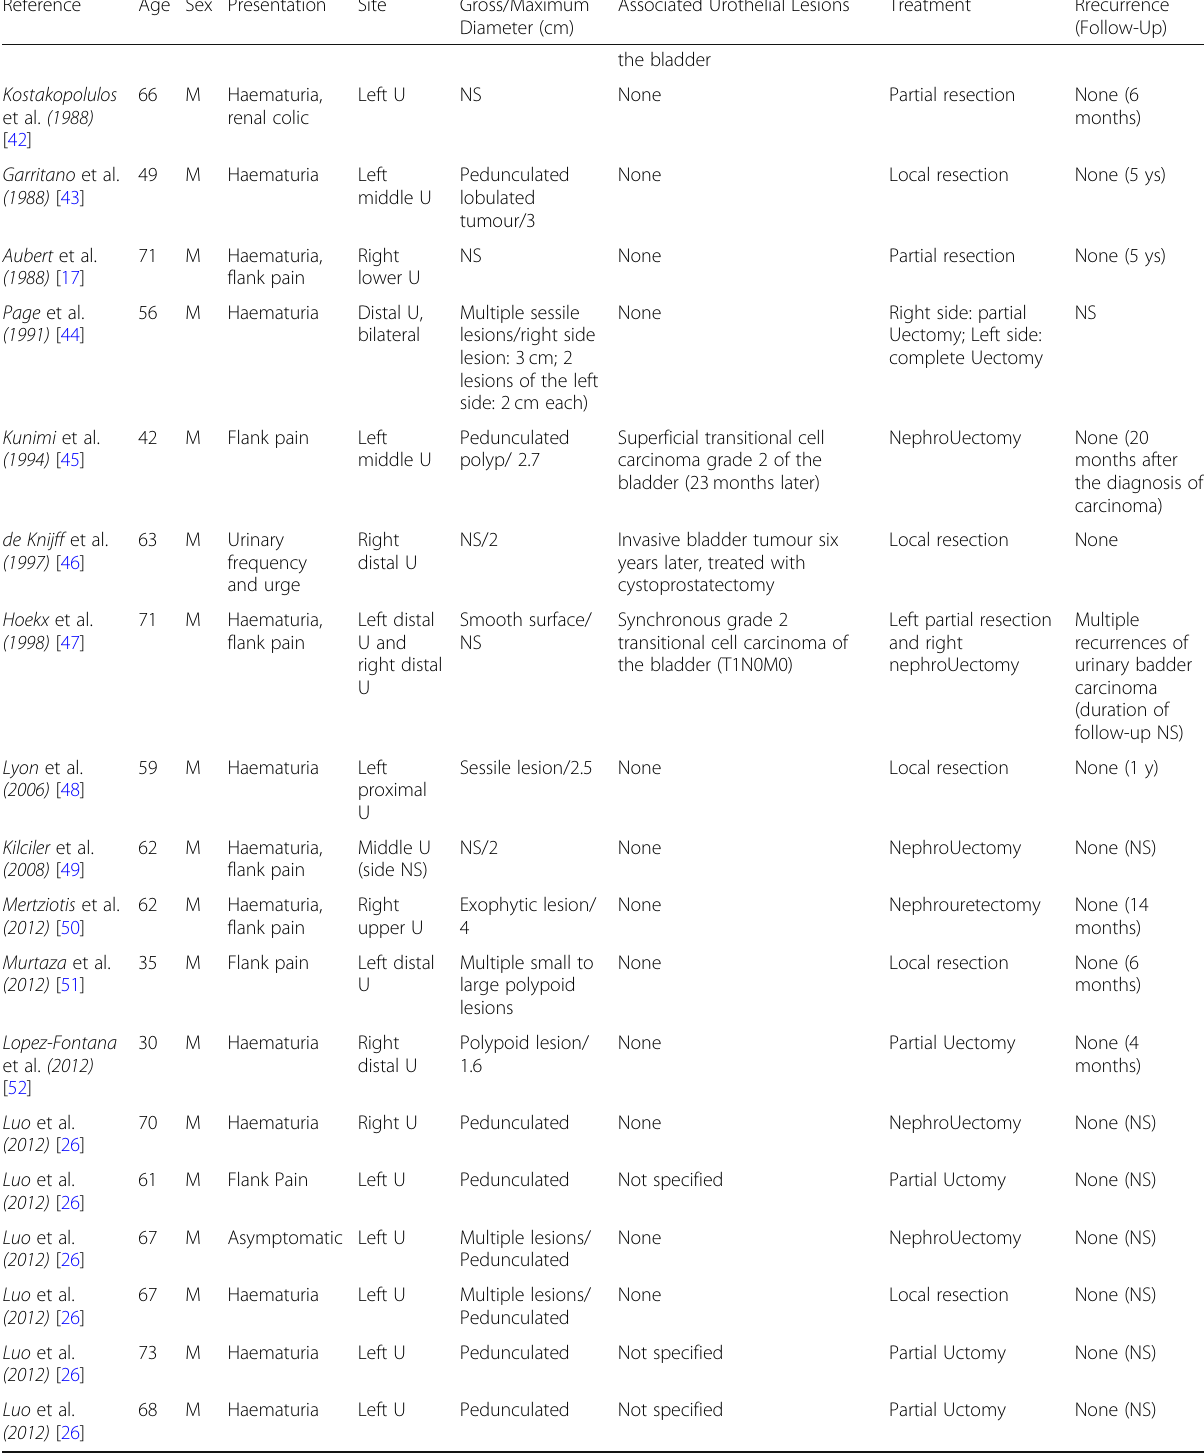
Table 2 IUP of the ureter (U) previously reported in the English Literature (NS = Not Stated; NA = Not Assessed) (Continued)